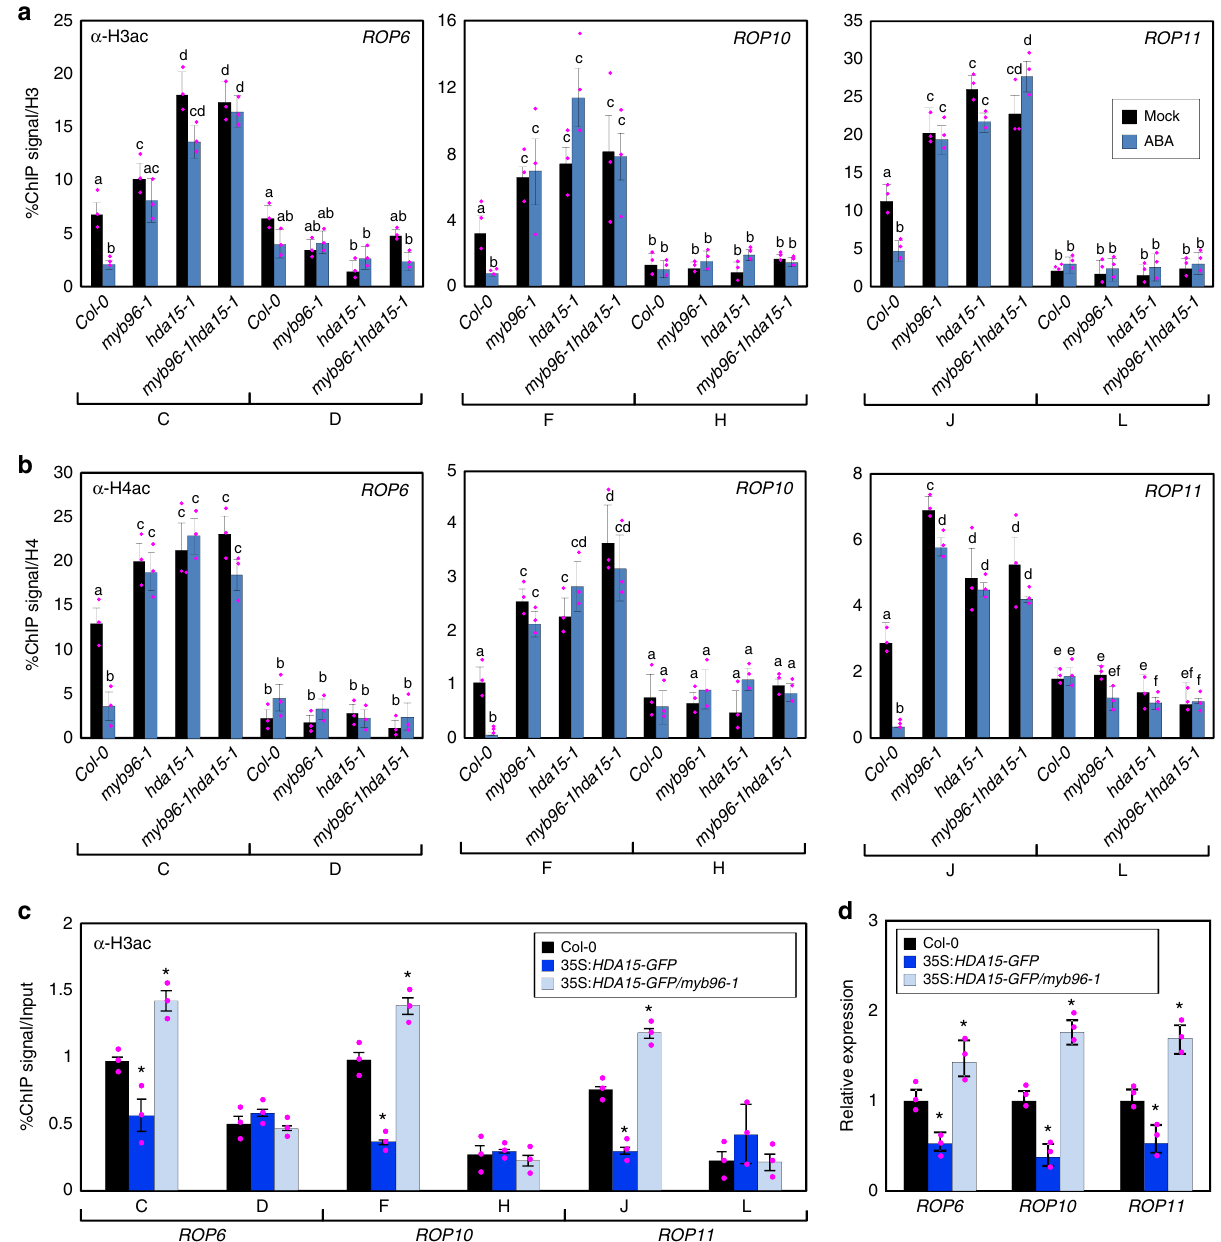
Fig. 6 HDA15 and MYB96 co-regulate histone deacetylation at ROP loci. a Effects of abscisic acid (ABA) on H3ac accumulation at the ROP promoters in myb96-1 , hda15-1 , and myb96-1hda15-1 mutants. b Effects of ABA on H4ac accumulation at the ROP promoters. In a , b , 2-week-old seedlings grown under long days (LDs) were transferred to MS-liquid medium supplemented with 20 μ M ABA and incubated for 24 h. Chromatin immunoprecipitation (ChIP) assays using anti-H3ac and anti-H4ac antibodies were performed. The indicated genomic regions (see Fig. 5) were analyzed by ChIP-quantitative PCR. Three independent biological replicates were averaged, and statistical signi fi cance of the measurements was analyzed by analysis of variance (ANOVA) (one-way ANOVA with Fisher ’ s post hoc test, * P < 0.05). Different letters represent a signi fi cant difference at P < 0.05. Bars indicate the standard error of the mean. c H3ac levels at the ROP loci in 35S: HDA15-GFP and 35S: HDA15-GFP / myb96-1 . d Transcript accumulation of ROP genes in wild type, 35S: HDA15- GFP , and 35S: HDA15-GFP/myb96-1 . In c , d , 2-week-old seedlings grown under LDs were harvested. Statistically signi fi cant differences between the wild- type and transgenic plants (Student ’ s t test, * P < 0.05) are indicated by asterisks. Source data are provided as a Source Data fi